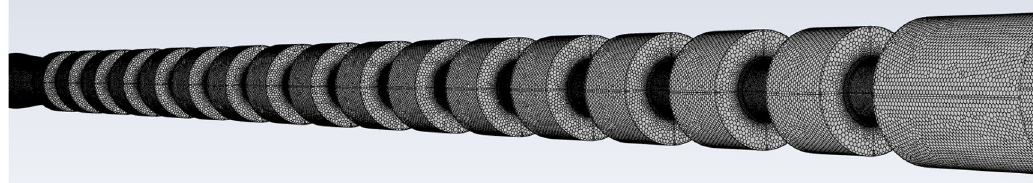
Fig. 6 Meshed CAD of the 4.5–9 mm internals geometry